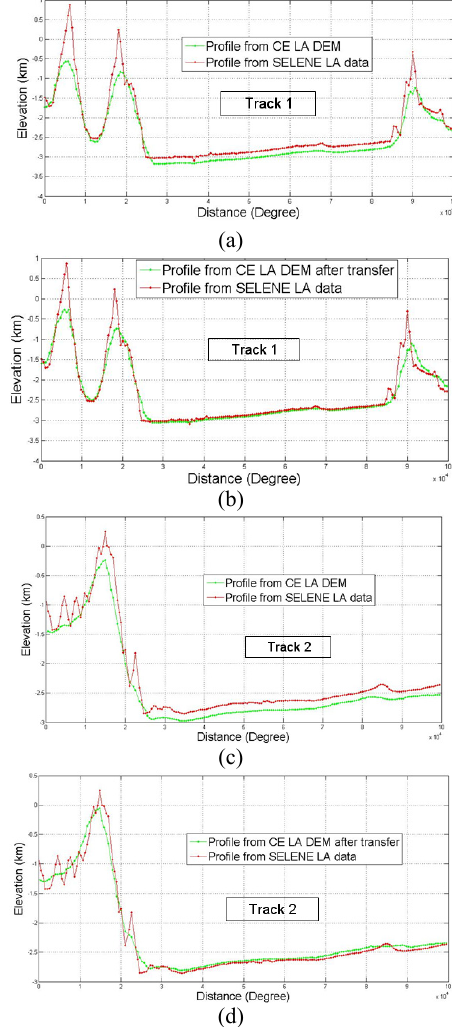
Figure 5. Profiles comparison between the SELENE and Chang’E-1 data sets, (a) and (b): the profiles from track 1 before and after transformation, respectively, (c) and (d): the profiles from track 2 before and after transformation,